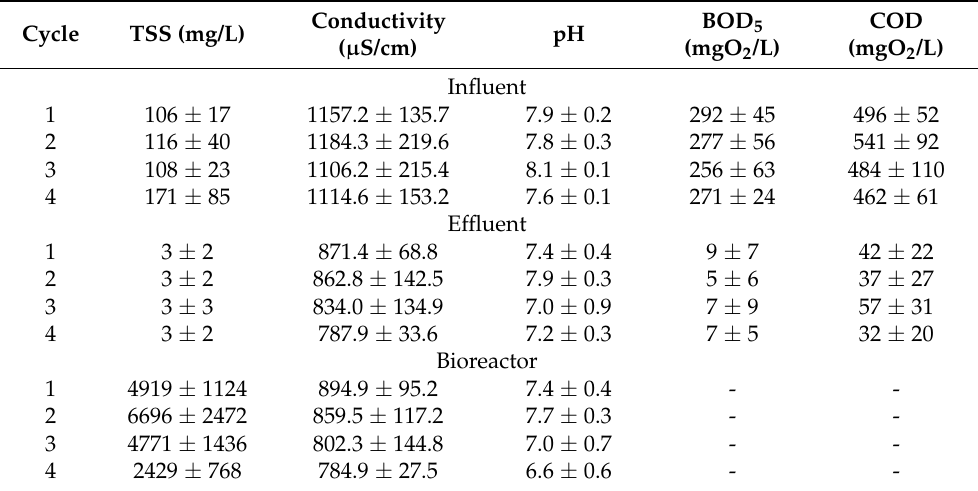
Table 2. Physicochemical parameters for influent and effluent (TSS, conductivity, pH, BOD 5 and COD) and bioreactor (TSS, conductivity and